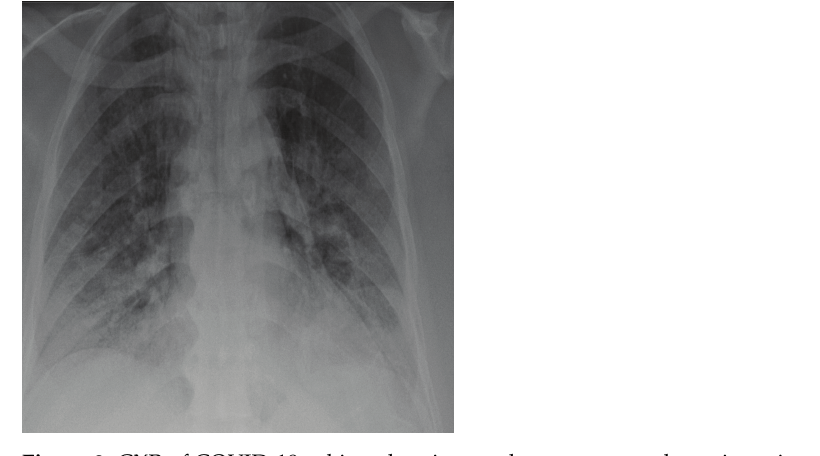
Figure 2. CXR of COVID-19 subject showing moderate to severe lung tissue involvement.